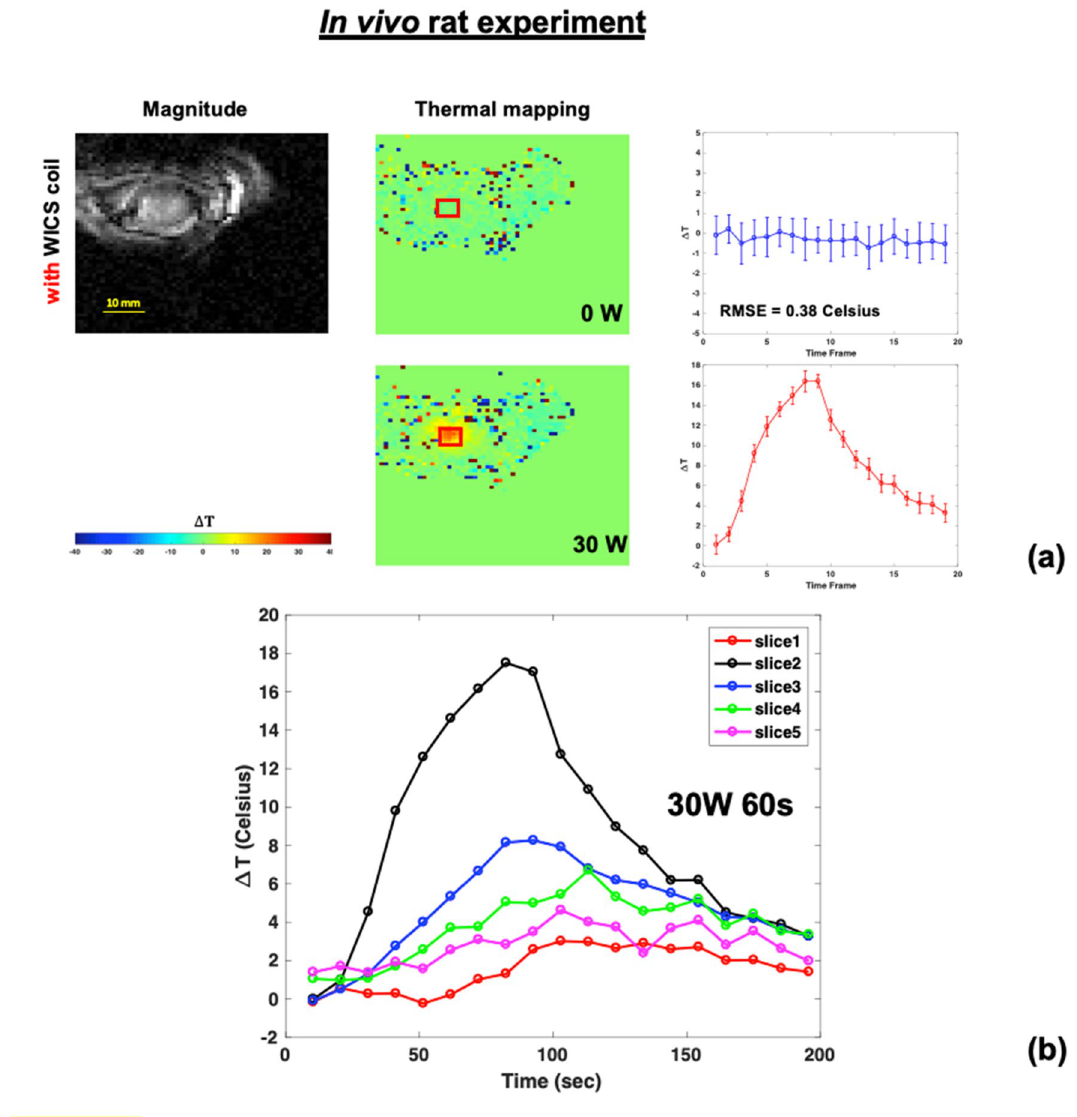
Figure 11. ( a ) The magnitude image and the corresponding temperature map marked with the location of ROI in the HIFU in vivo rat experiment, without (upper) and with (lower) heating. ( b ) Temperature response of in vivo experiment where focal point located in slice